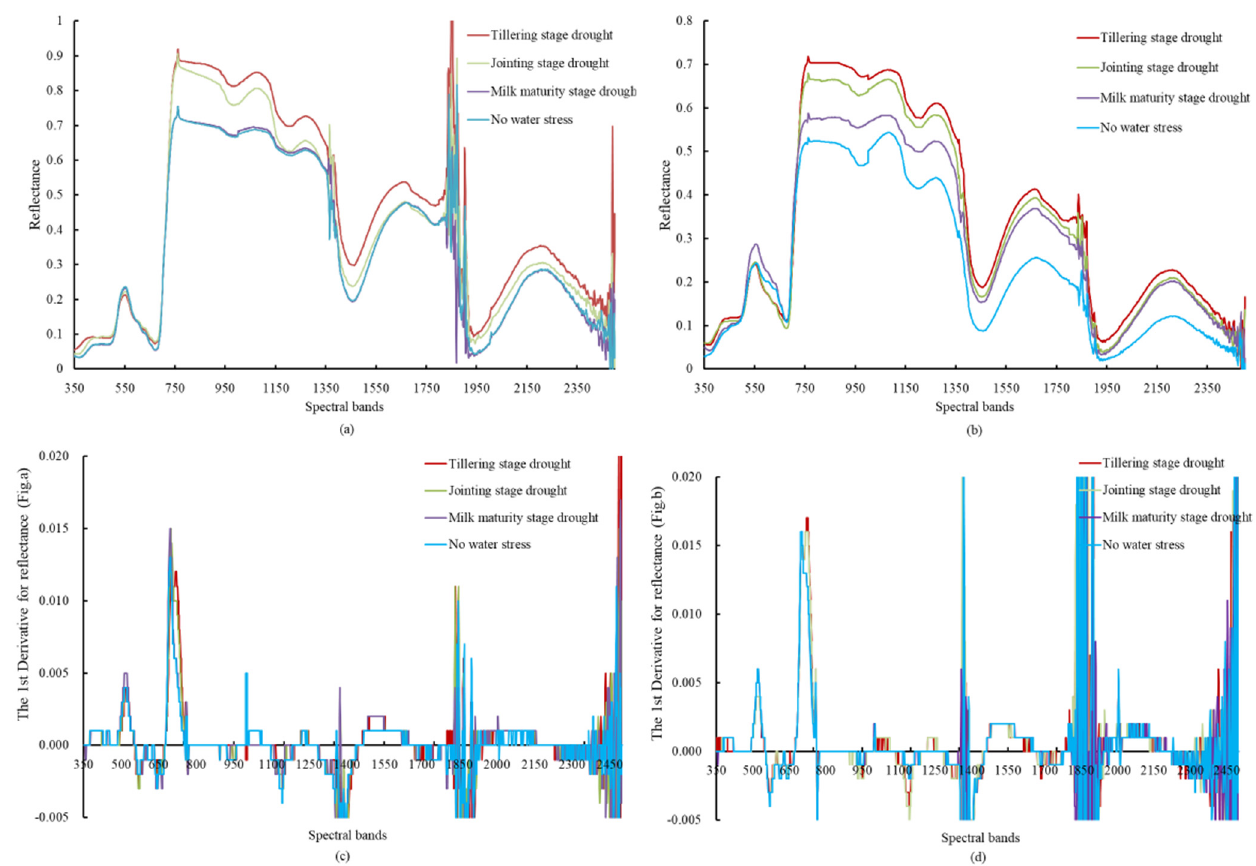
Figure 1. Wheat spectral characteristics for different growing stages. ( a ) Spectra for wheat measured on Jan 9 and ( b ) Mar 5. ( c ) The 1st derivative curve for ( a ). ( d ) The 1st derivative curve for ( b ).